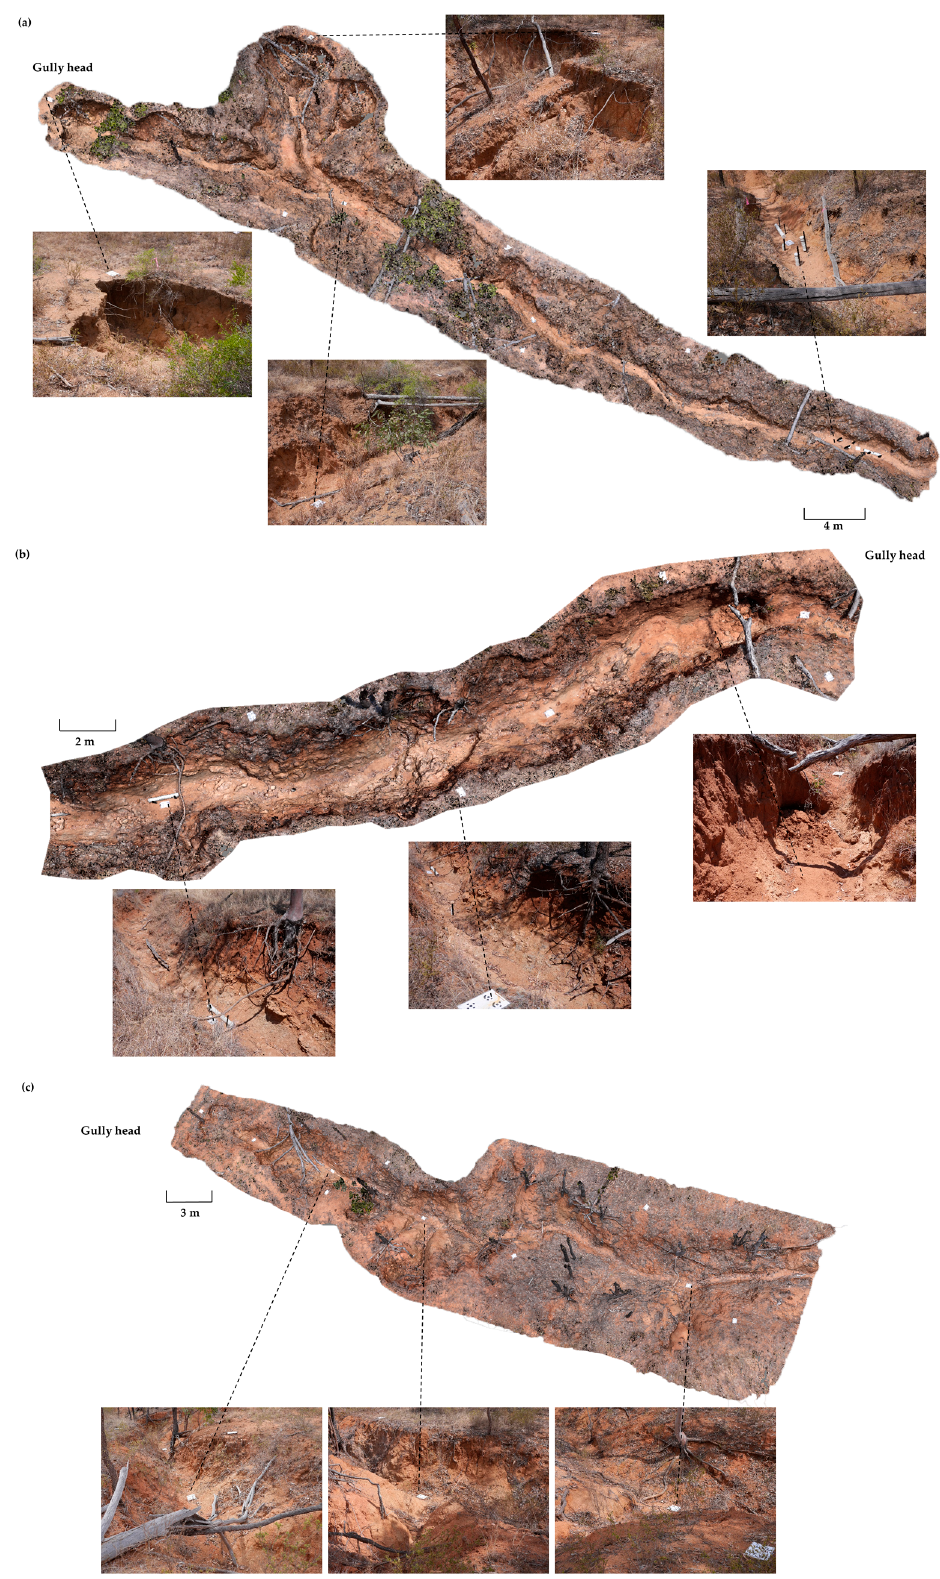
Figure 3. 3D Ground Digital Surface Model (DSM) of: ( a ) G1 gully; ( b ) G3 gully; and ( c ) G6 gully, with inset photographs at specific points used in SfM-MVS reconstruction. Note, the scale bar does not relate to inset photographs.